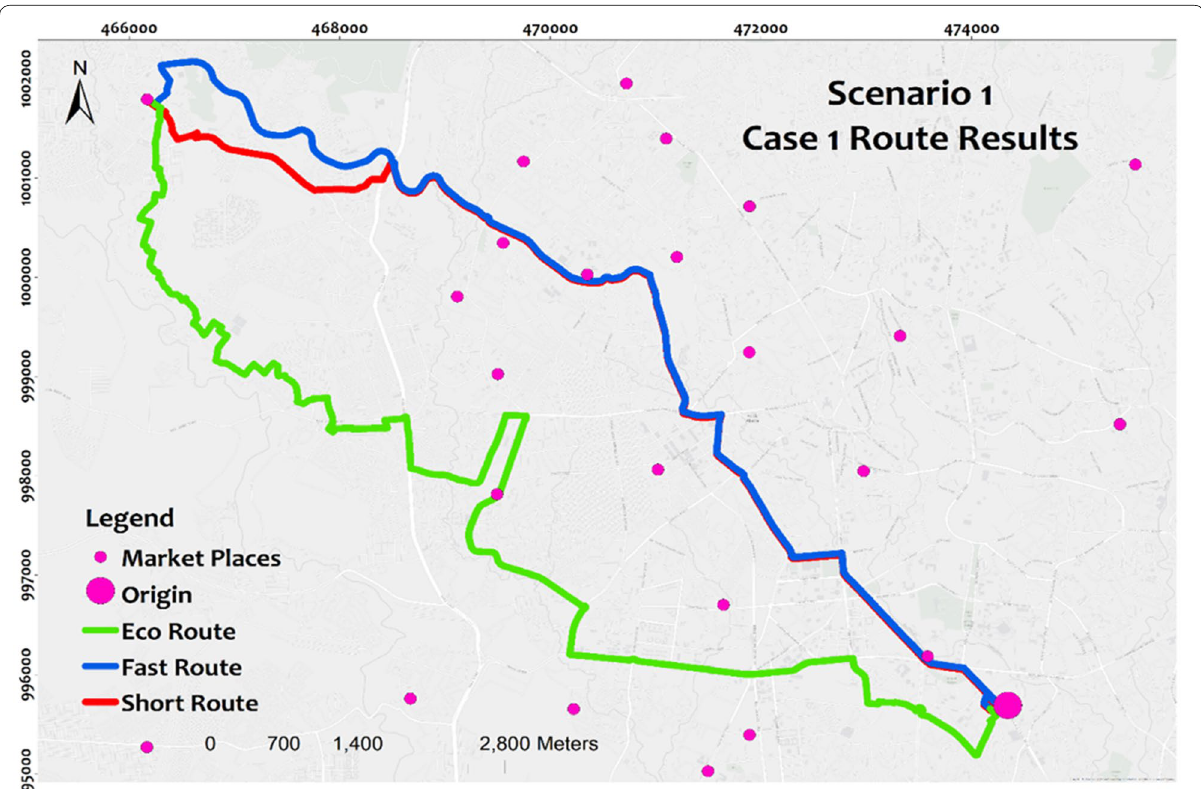
Fig. 5 Scenario 1 Case 1